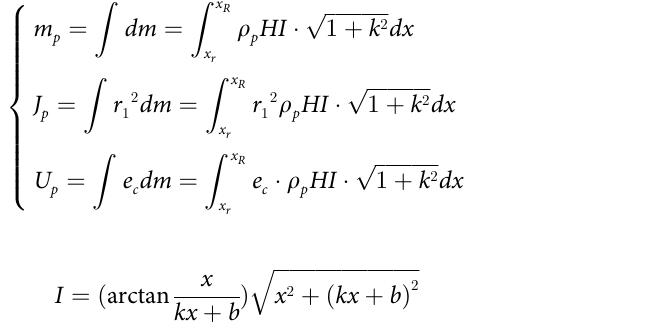
Fig 6 indicates the schematic diagram of weight-reducing hole module calculation. Assum-